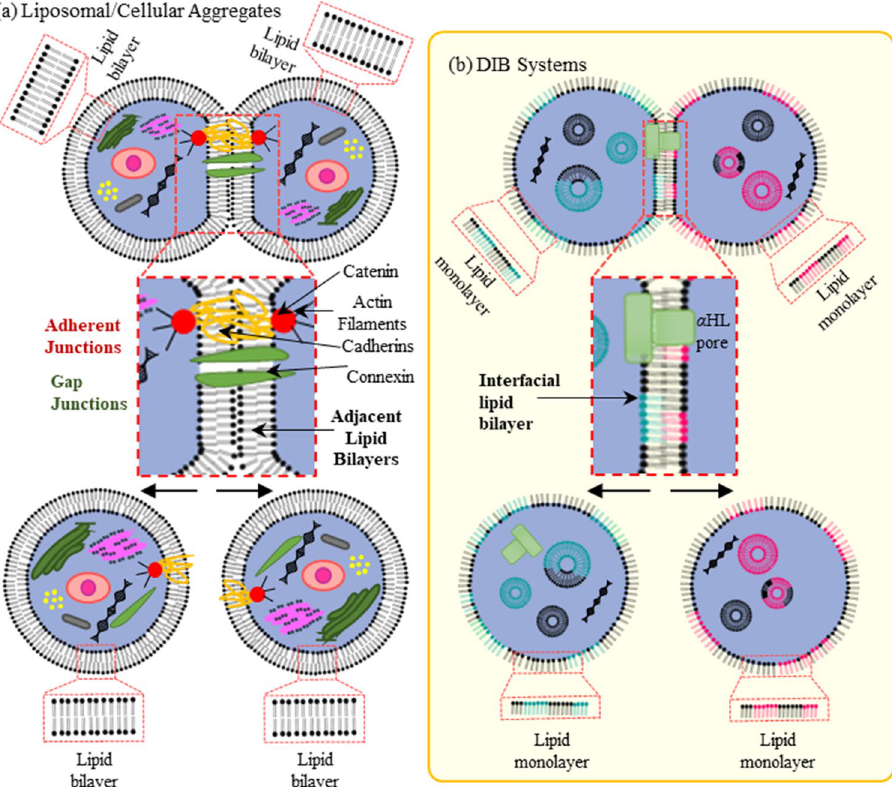
Figure 1. Schematic representation of adhesion in ( a ) cellular tissues and ( b ) DIB assemblies. According to the differential adhesion hypothesis (DAH), tissues may be described as emulsive systems which